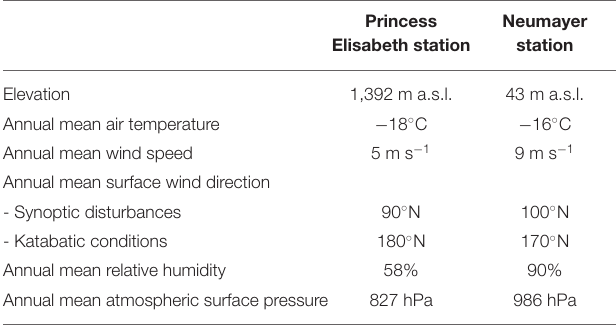
TABLE 1 | Meteorological conditions at Princess Elisabeth and Neumayer stations.